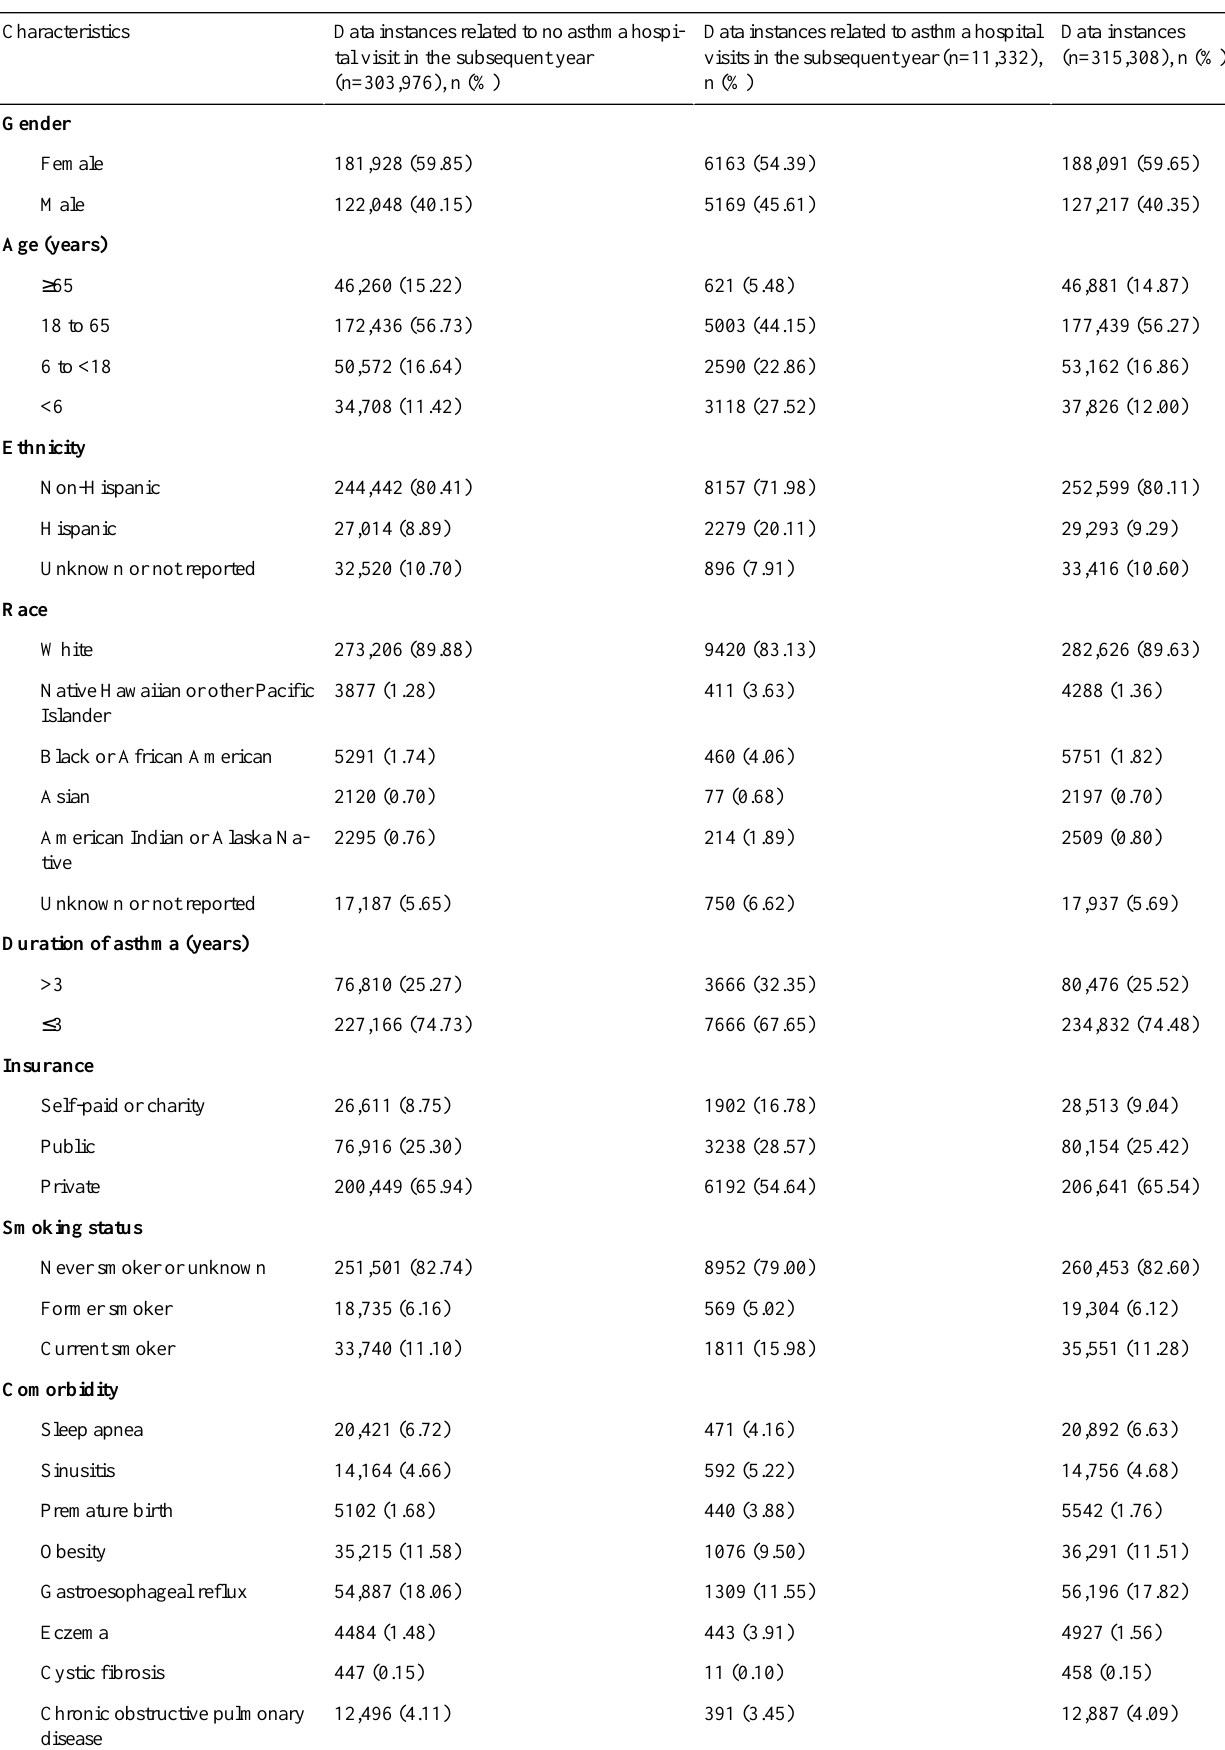
Table 1. Demographic and clinical characteristics of the Intermountain Healthcare patients with asthma between 2005 and